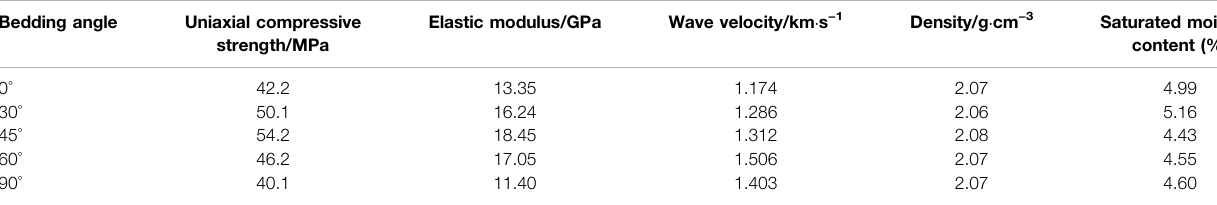
TABLE 2 | Average value of key parameters of unanchored rock samples. Bedding